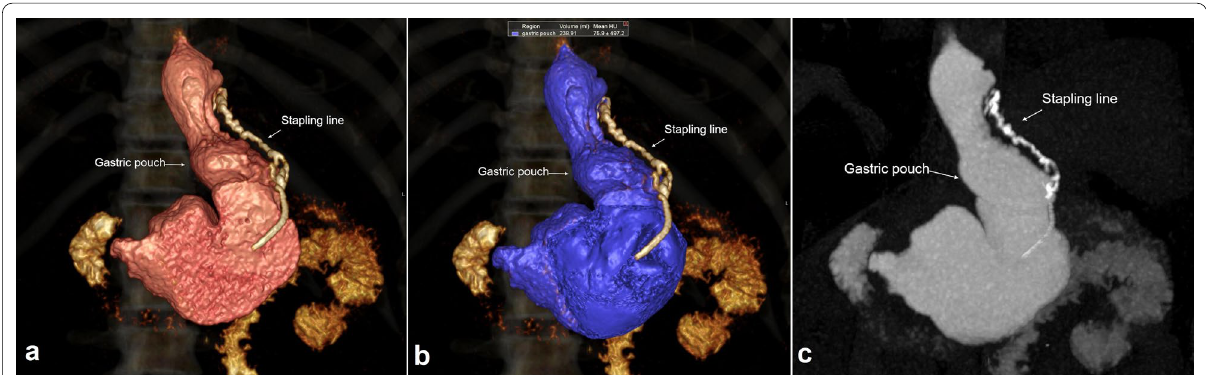
Fig. 1 Gastric pouch dilatation after sleeve gastrectomy. 3D volume rendered image ( a ) optimally demonstrates the intact stapling line with significantly dilated gastric pouch that measures about 239 ml at CT gastric volumetry image ( b ). MIP image ( c ) resembles the traditional barium study and demonstrates anatomical changes including the radiodense intact stapling line as well as pouch